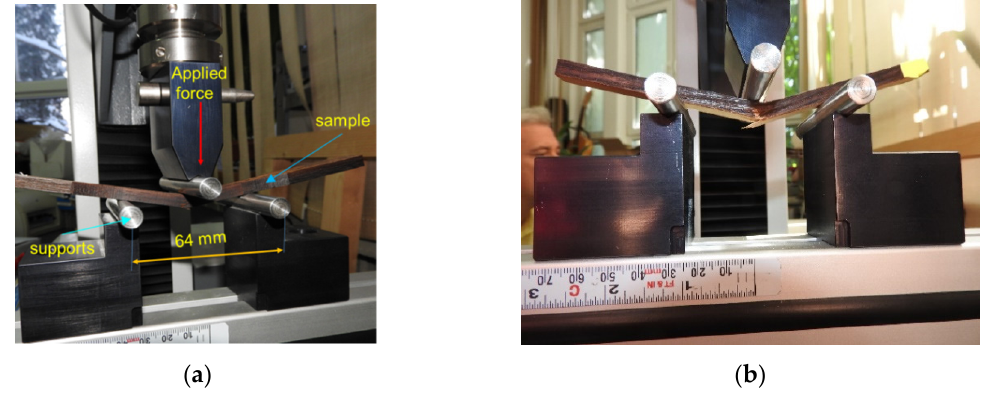
Figure 3. Three-point bending test: ( a ) the principle of loading; ( b )the breaking of samples.